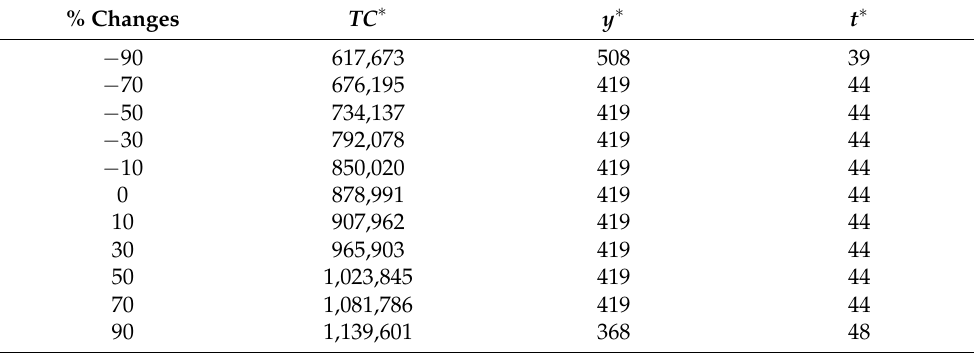
Table 5. Sensitivity analysis of the feeding cost ( z ).